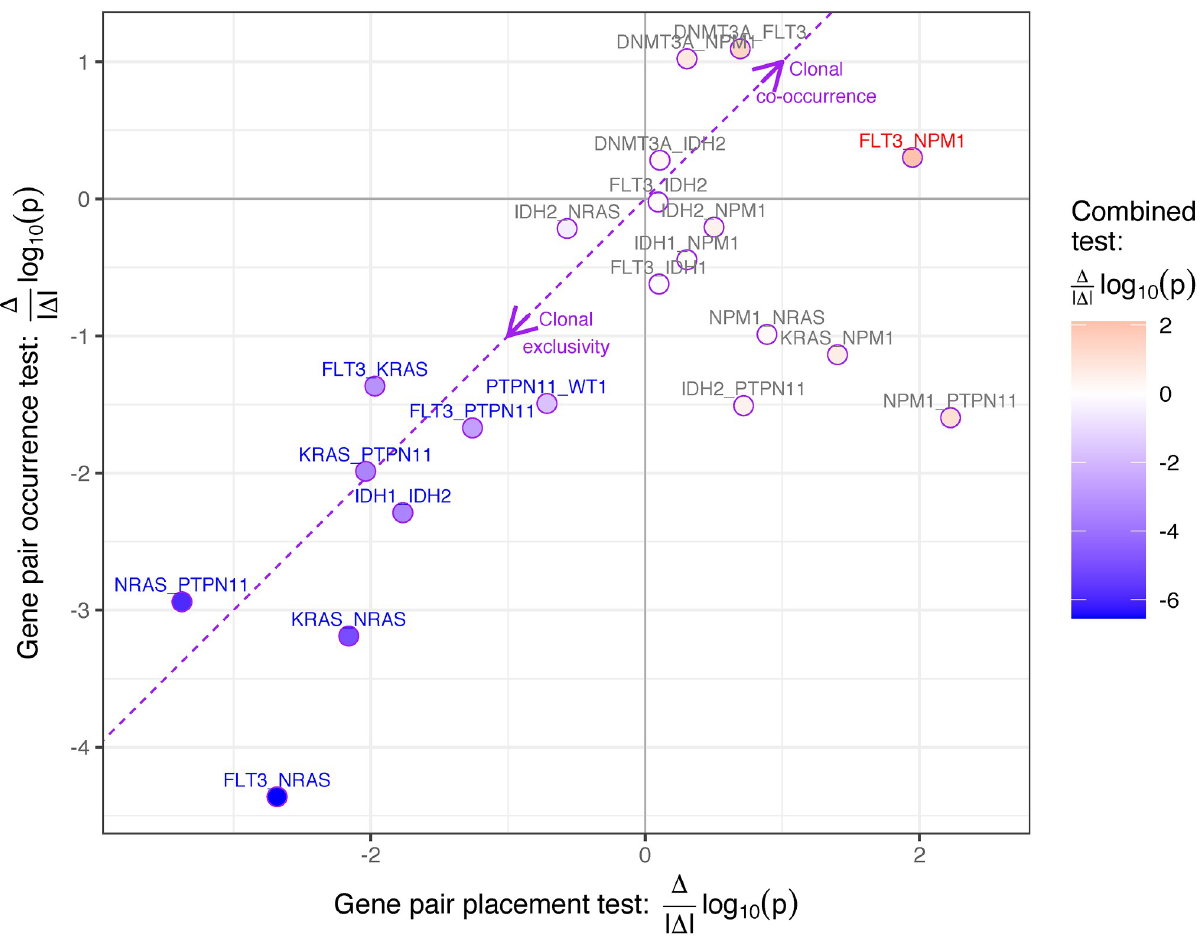
Fig 7. Significance of clonal co-occurrence or exclusivity of the three GeneAccord tests for the AML cohort. For the AML cohort, we plot the significance of clonal co-occurrence or exclusivity by computing the log 10 p-value and including the sign of the effect D occurrence, negative indicating clonal exclusivity) for the three geneAccord tests: The x-axis depicts the placement test, the y-axis the occurrence test and the colouring the combined test (red indicating clonal co-occurrence, blue indicating clonal exclusivity). The labels of the significant gene pairs of the combined test, after Benjamini-Hochberg correction (Table 1), are also